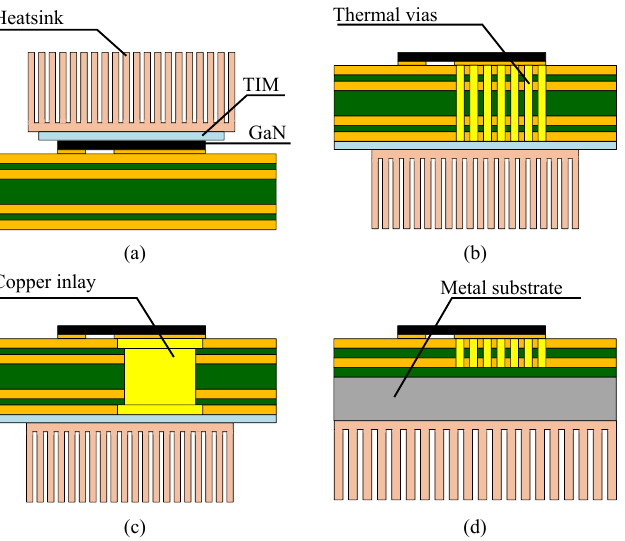
Figure 2. Heat dissipation methods: ( a ) top-side cooled, ( b ) bottom-side cooled with vias, ( c ) bottom-side cooled with copper inlay, and ( d ) insulated metal